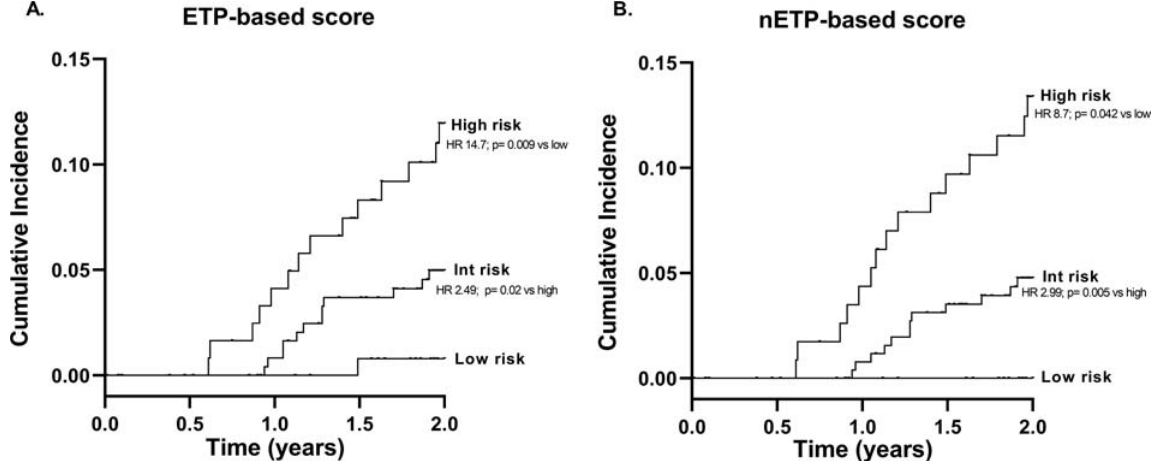
Fig. 4 CumulativeincidenceofE-DRaftercurativesurgeryforbreastcancerstrati fi edbyETP-basedscore( A )andnETP-basedscore( B ).(A)TheE-DRratesby the ETP-based score were 0.8, 4.9, and 11.8% in the low-, intermediate-, and high-risk categories. Low versus high risk: HR ¼ 14.7 (95% CI: 1.94 – 112; p ¼ 0.009);Intermediateversushighrisk:HR ¼ 2.49(95%CI:1.15 – 5.39; p ¼ 0.020.(B)TheE-DRratesbythenETP-basedscorewere0,4.7,and13.5%inthe low-,intermediate-,andhigh-riskcategories.Lowversushighrisk:HR ¼ 8.70(95%CI:1.08 – 70; p ¼ 0.042);intermediateversushighrisk:HR ¼ 2.99(95%CI: 1.40 – 6.41; p ¼ 0.005). CI, con fi dence interval; E-DR, early disease recurrence; ETP, endogenous thrombin potential; HR, hazard